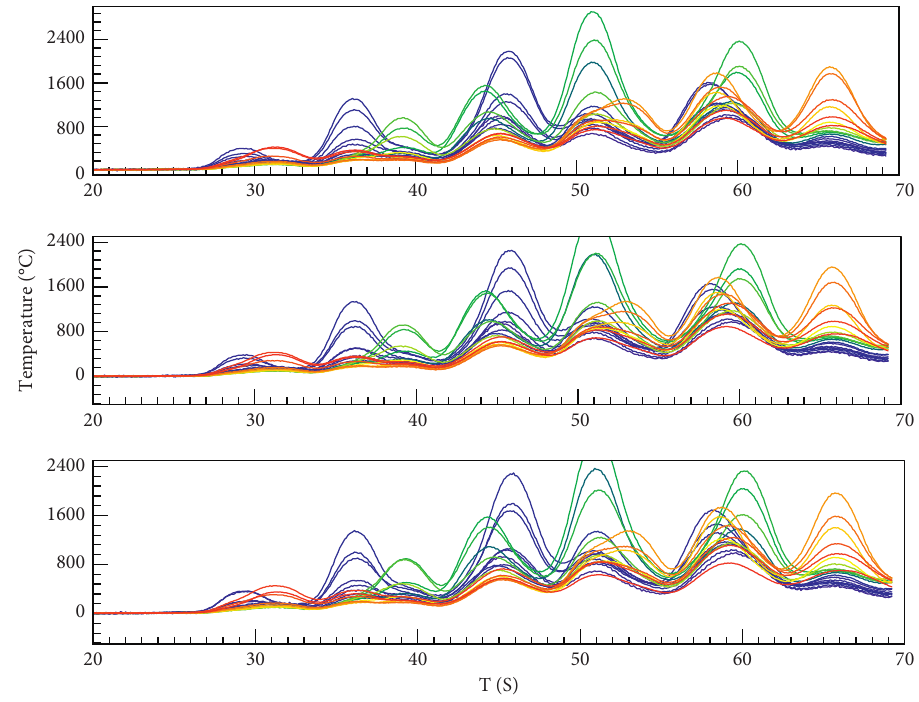
Figure 5: Performance test data